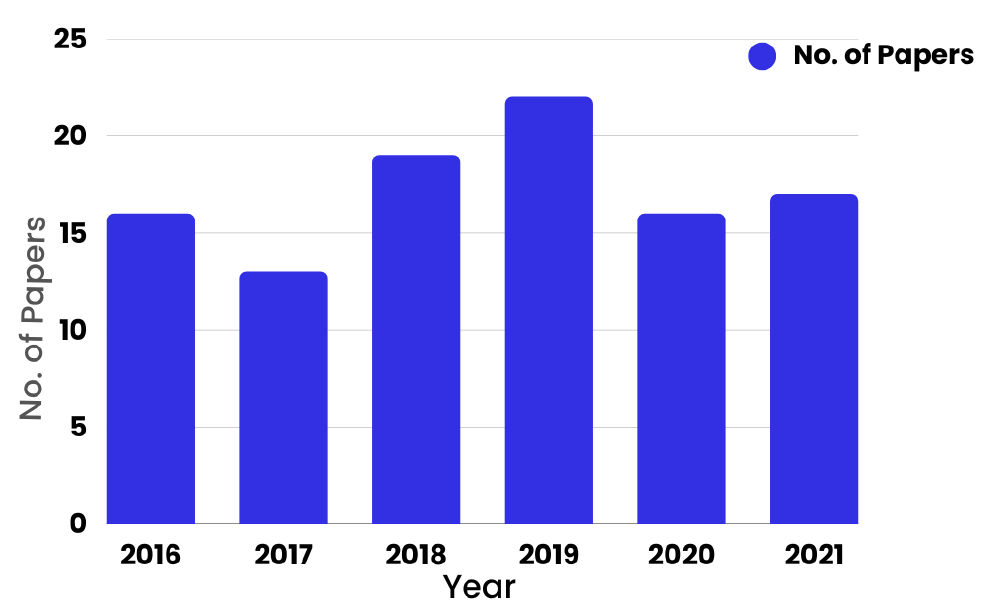
Figure 6. Year-wise trends in publications in the field of